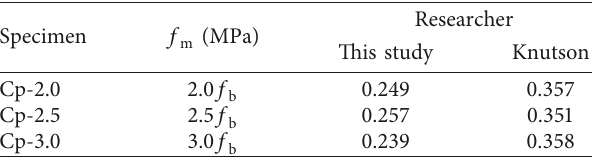
Figure 13: Comparisons of predicted stress-strain curves with test results. Table 6: Comparisons of normalized root-mean-square error obtained from each stress-strain